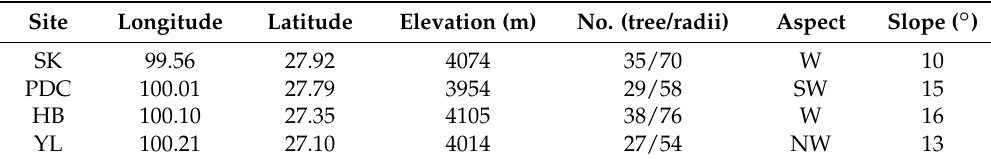
Table 1. Sampling sites information.